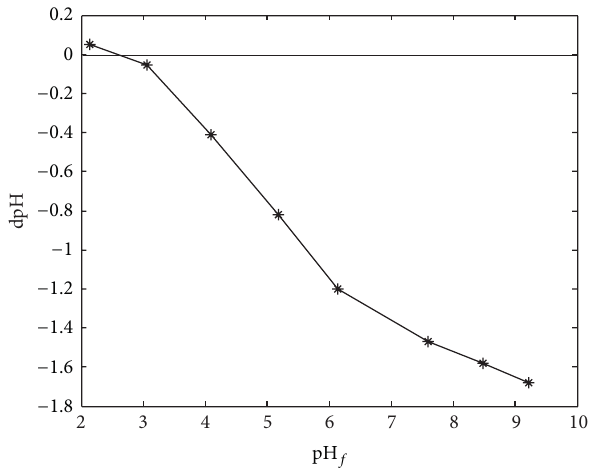
Figure 5: Point zero charge of palm tree male